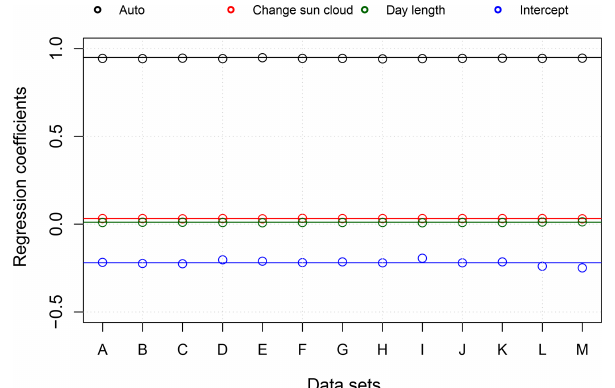
tions (points) for leave-one-out cross validation and using all sta- tions (straight